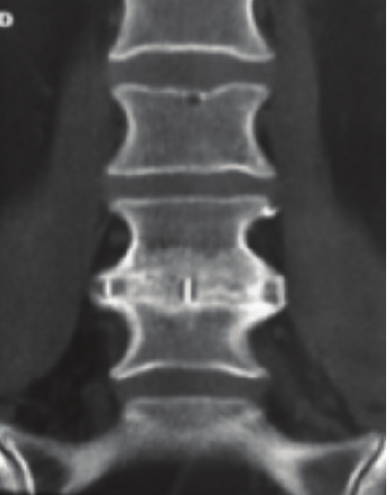
Figure 3: Change in minimum, maximum, and average leg pain (LP) from preoperative to last followup (mean 11.5 months).